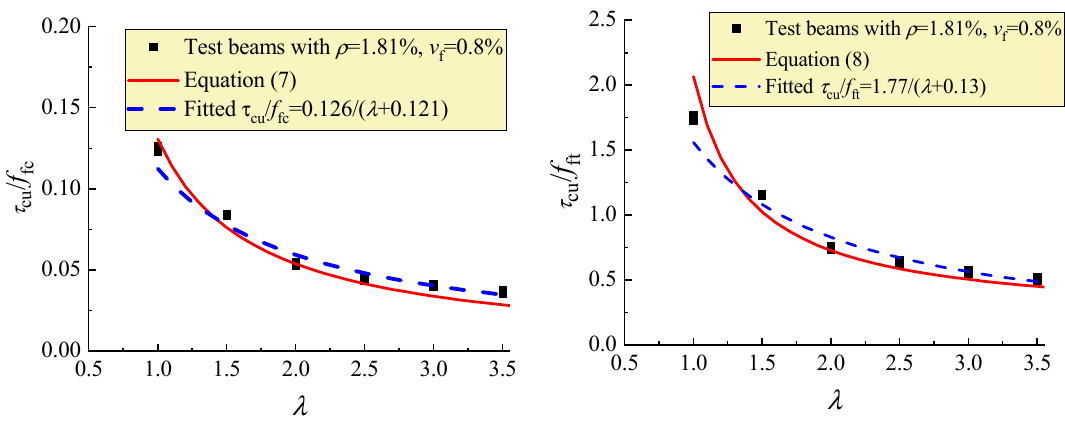
Figure 14. Variations of τ cu / f c and τ cu / f ft with λ . At the same time, Equation (9) proposed by Rebeiz [29] and Equation (10) proposed by Kim and Park [30] are also used to verify the test results of this study. For the convenience of description and comparison, the symbols with the same meaning are unified as much as